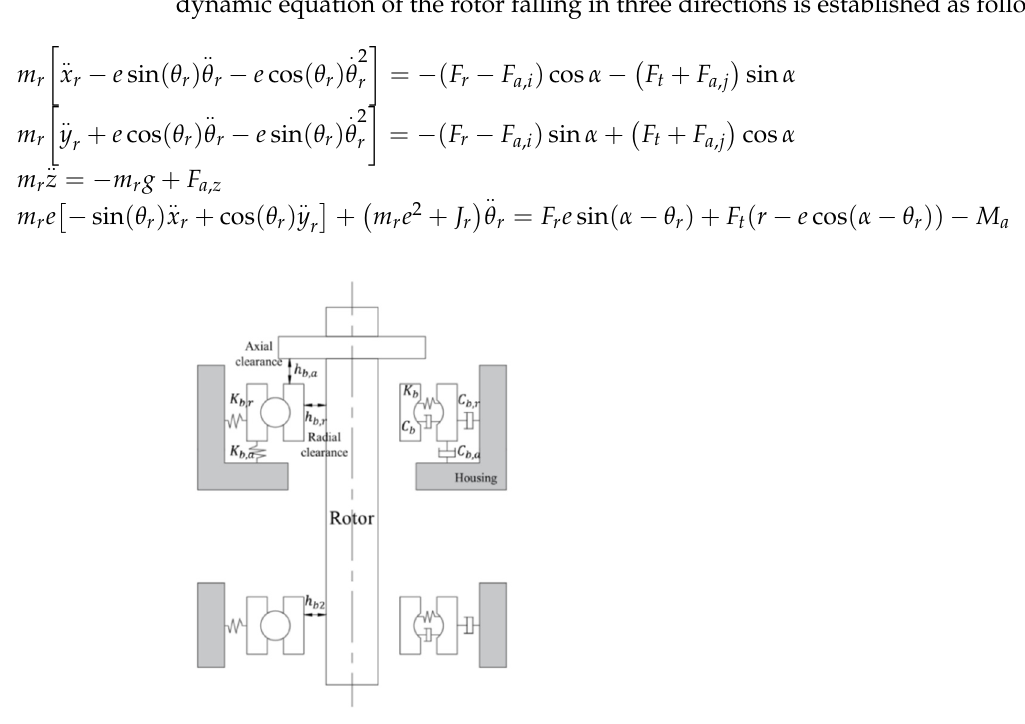
Figure 3. Contact model of the rotor and TDB inner ring.